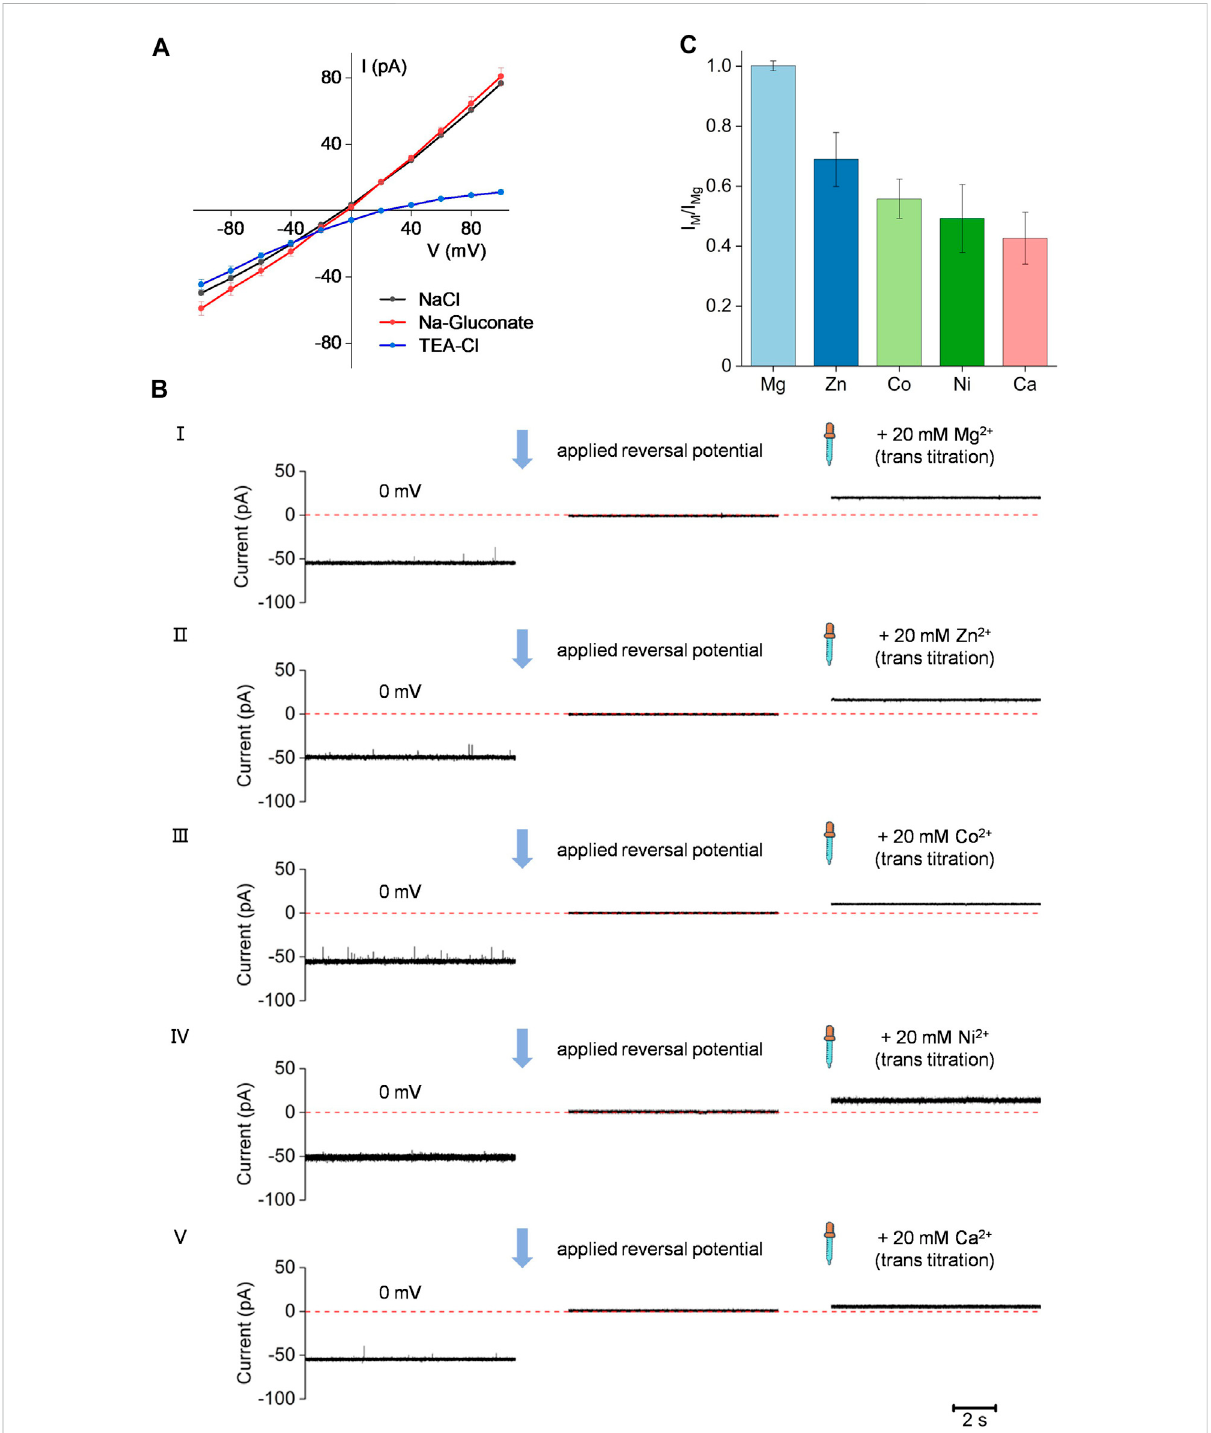
FIGURE 4 The Bpss1228 channel is permeable to cation. (A) The current-voltage relationship of the CorA demonstration cation selectivity. Cis-chamber solutionsare150 mMNaCl,andthedifferentcolorofdotsrepresentdifferentbuffersintrans-chamber,blackdots(150 mMNaCl),reddots(150 mM Na-Gluconate)andbluedots(150 mM TEA-Cl), all buffered with10 mMHEPES, pH7.5 (Mean±SE, n = 3). (B) The representcurrenttraces appliedat 0 mV or reversal potential, and added in 20 mM divalent cations. From I to V represent Mg 2+ , Zn 2+ , Co 2+ , Ni 2+ , Ca 2+ , respectively. The cis- chamber contained 300 mM NaCl, and the trans-chamber was loaded with 30 mM NaCl, all buffered with 10 mM HEPES, pH 7.5. (C) Bar chart showing different current change after adding the divalent cations described in (B) (Mean ± SE, n =